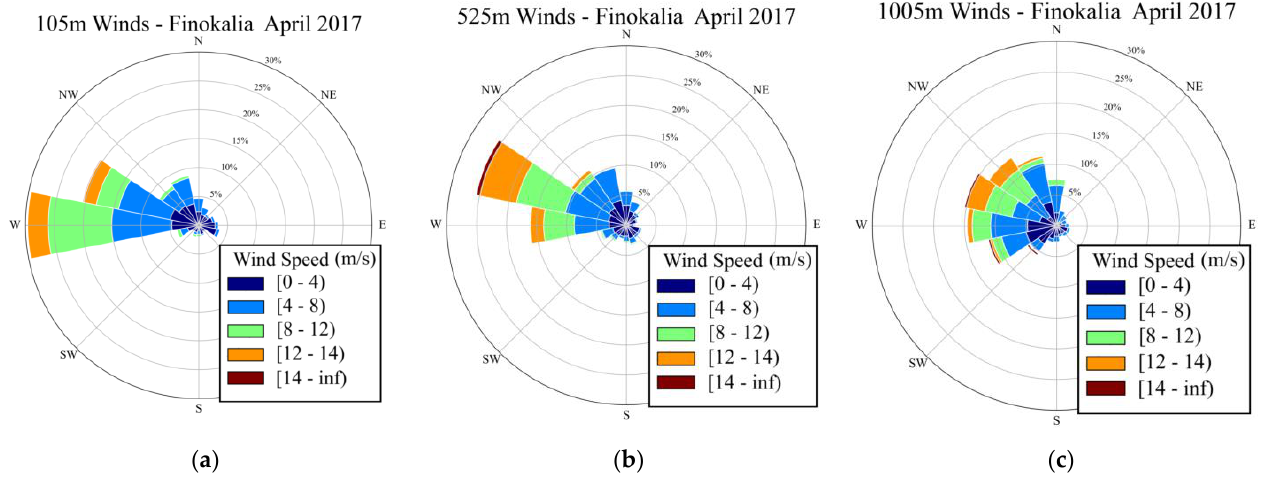
Figure 14. Wind Rose from Halo Wind Doppler Lidar during 1 – 26 April 2017 for ( a ) 105 m level, ( b ) 525 m level and ( c ) 1005 m level above ground.